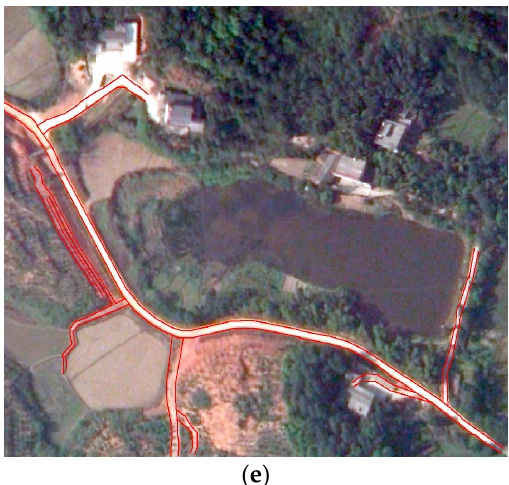
Figure 11. Road extraction process. ( a ) edge detection result, ( b ) candidate segment identification result, ( c ) candidate segment linking result, ( d ) inference of missing segments, ( e ) overlay of remote